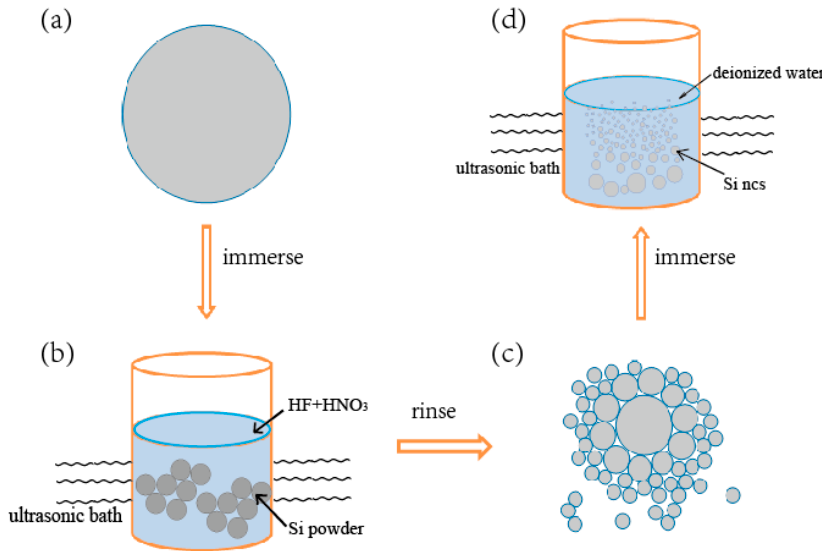
Figure 1. Schematic of the silicon NC fabrication process: ( a ) A grain of silicon powder; ( b ) silicon powder immersed in an ultrasonic bath with aqueous solution; ( c ) a silicon grain becomes loose after corroding; and ( d ) loose silicon grains are broken into suspended silicon NCs after another ultrasonic treatment with water.